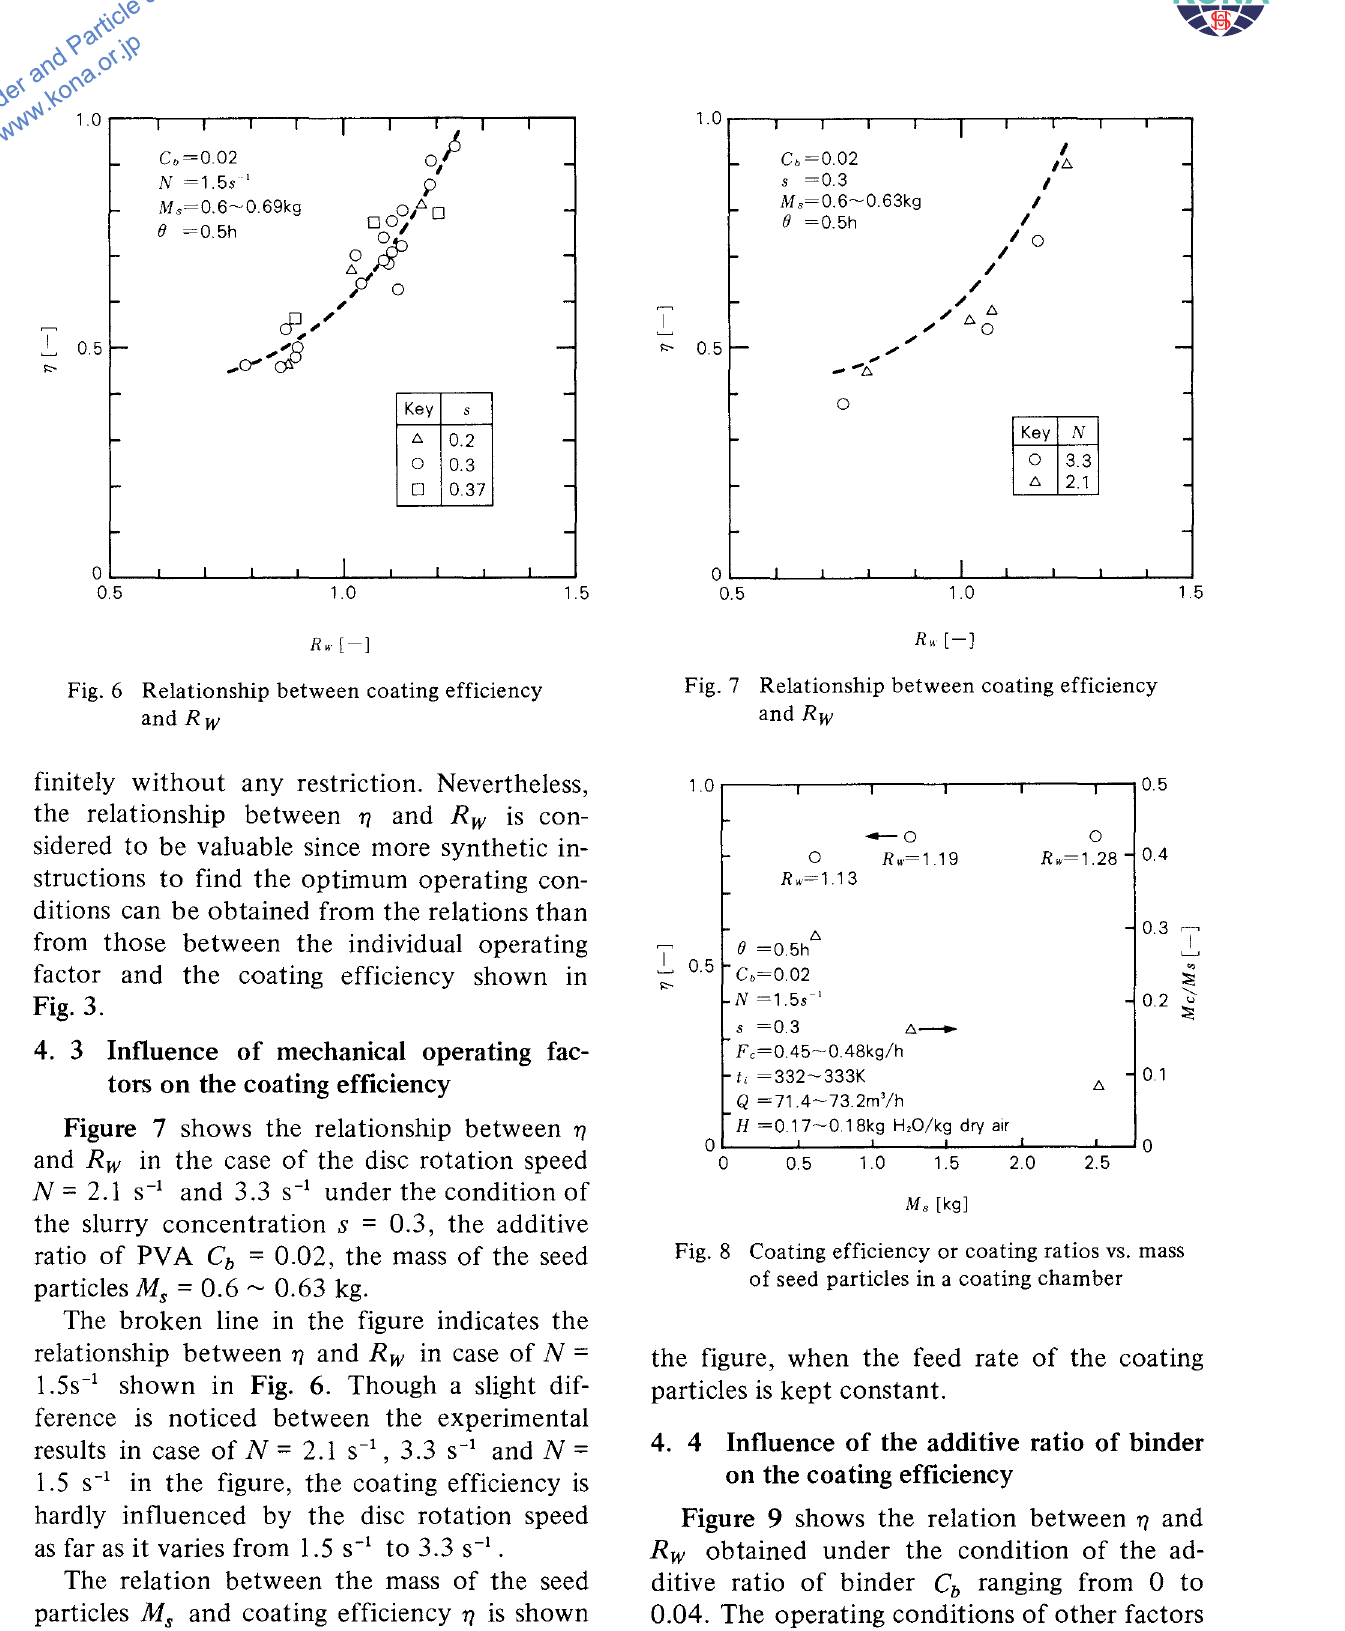
Fig. 7 Relationship between coating efficiency